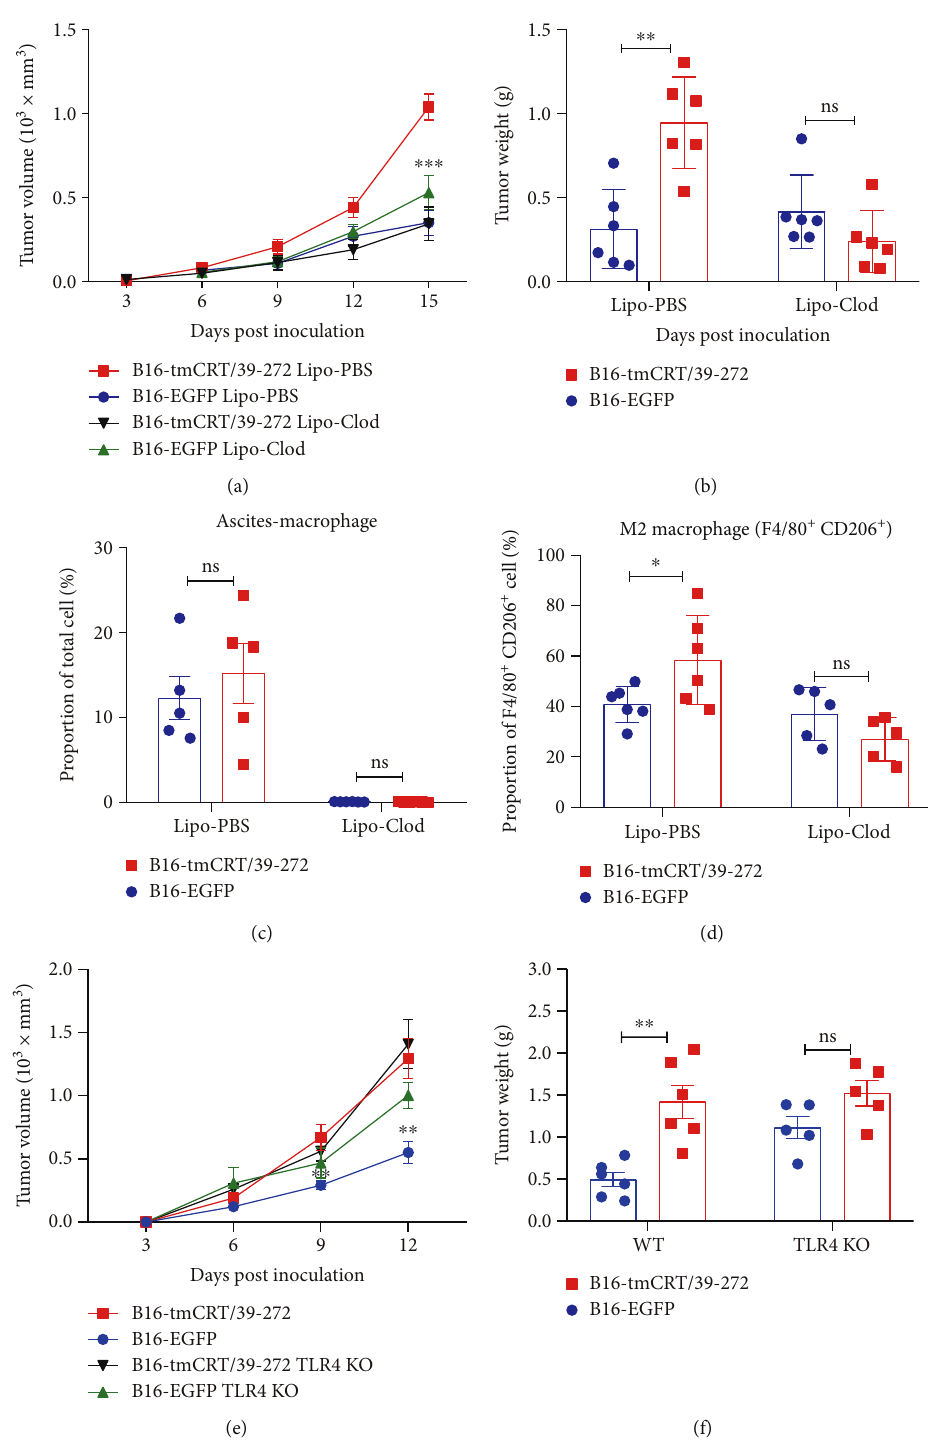
Figure 3: Macrophage depletion or TLR4 KO reduced tumorigenesis and M2 polarization in B16-tmCRT/39-272-inoculated mice. (a – d) Female C57BL/6 mice ( n = 6 ) were s.c. injected with B16-EGFP or B16-tmCRT/39-272 cells ( 5 × 105/100 μ L/mouse), then i.p. injected with Lipo-Clod or Lipo-PBS (100 μ L/mouse) every 3 days. (a) Tumor growth curves. (b) Tumor weights. (c) Ascites macrophages were collected from the mice 15 days postinoculation. The proportions of total macrophages (CD11b + F4/80 + ) were analyzed by FACS. (d) Tumor tissues were collected from mice 15 days postinoculation. The proportions of M2 macrophages (F4/80 + CD206 + ) were analyzed by FACS. (e and f) Female C57BL/6 ( n = 6 ) or TLR4-KO C57BL/6 mice ( n = 5 ) were s.c. injected with B16-EGFP or B16-tmCRT/39-272 cells (5 × 10 5 /100 μ L/mouse) and the diameter of solid tumors at the injection sites was evaluated every 3 days thereafter. (e) Tumor growth curves. (f) Tumor weights. The experiments were repeated three times. ∗ P < 0 : 05 , ∗∗ P < 0 : 01 , ∗∗∗ P < 0 : 001 , ns: not signi fi